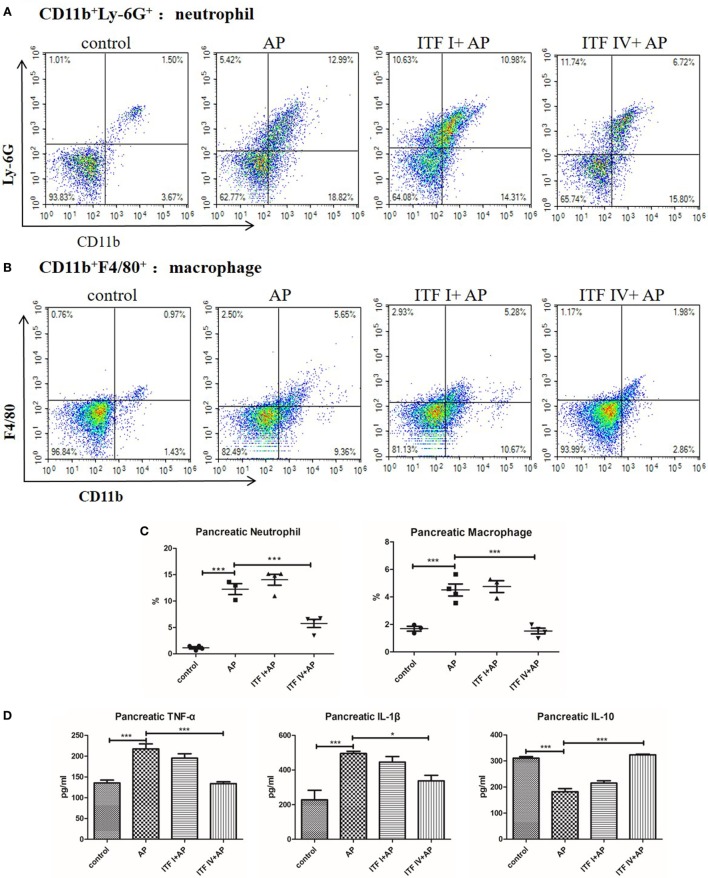
Effects of ITF IV on AP-mediated neutrophil and macrophage infiltration and cytokines production in the pancreas. Mice were fed with 5% ITF I or ITF IV supplemented diets for 72 h before AP induction by caerulein. Neutrophil and macrophage infiltration and cytokine production in the pancreas were determined as described in Section “Materials and Methods,” respectively. Representative graphs showed dot plots of Ly-6G+CD11b+ neutrophils (A) and F4/80+CD11b+ macrophages (B) in the pancreas and quantitative analysis of neutrophils and macrophages infiltration (C). Quantitative analyses of TNF-α, IL-1β, and IL-10 levels in the pancreas were performed by ELISA (D). Data shown are means ± SEM. *P < 0.05 and ***P < 0.001. AP, acute pancreatitis; ELISA, enzyme-linked immunosorbent assay; IL, interleukin; ITF, inulin-type fructans; TNF-α, tumor necrosis factor-α.